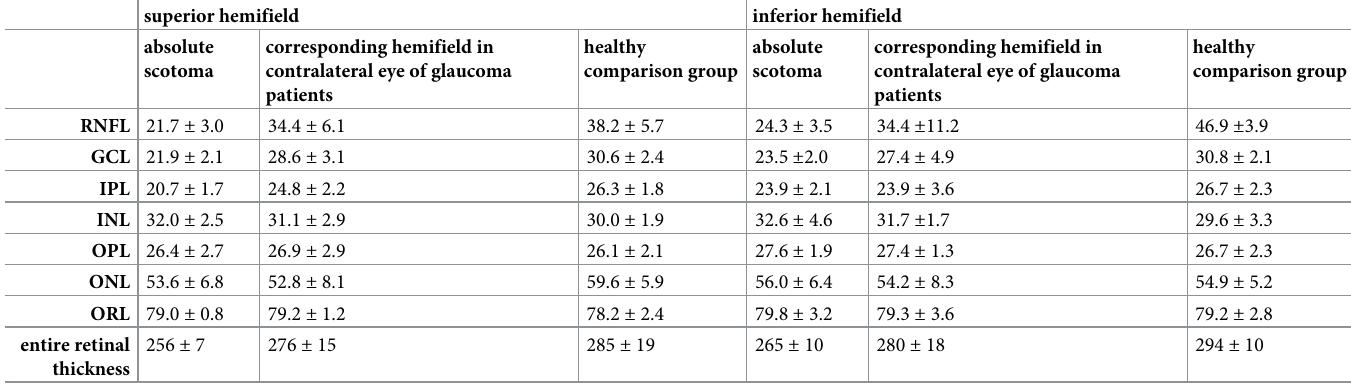
Table 4. Comparison of glaucomatous eyes and healthy control group. Mean thickness of the retinal layers and the entire retina as measured in the group of glaucoma patients and the healthy age-matched control group. Results are shown for the hemifields corresponding to the localization of the absolute visual field defect, corresponding hemifields of the contralateral eyes, and corresponding hemifields of the control group with respect to the localization of the scotoma in the superior or inferior half of the visual field.